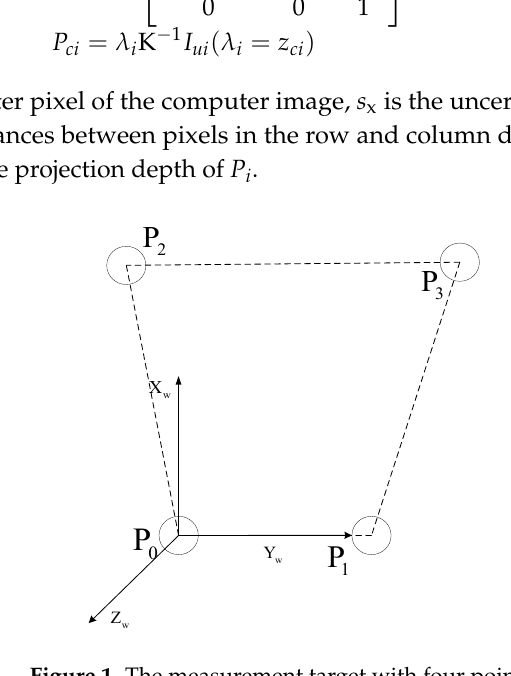
Figure 1. The measurement target with four points.